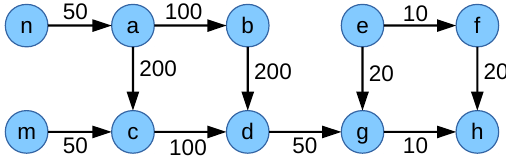
Figure 19. Topology of scenarios 25 to 28: Meshed network with shared bottleneck link d-g. The numbers specify the link speeds in